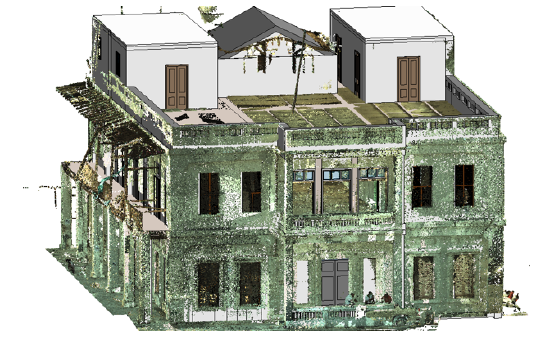
Figure 14: Creating the BIM model in Autodesk